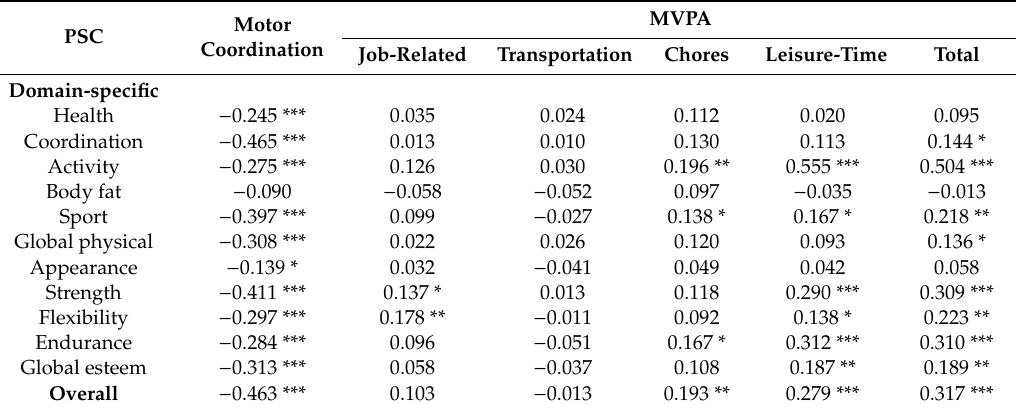
Table 2. Correlations between motor coordination, PSC, and MVPA.